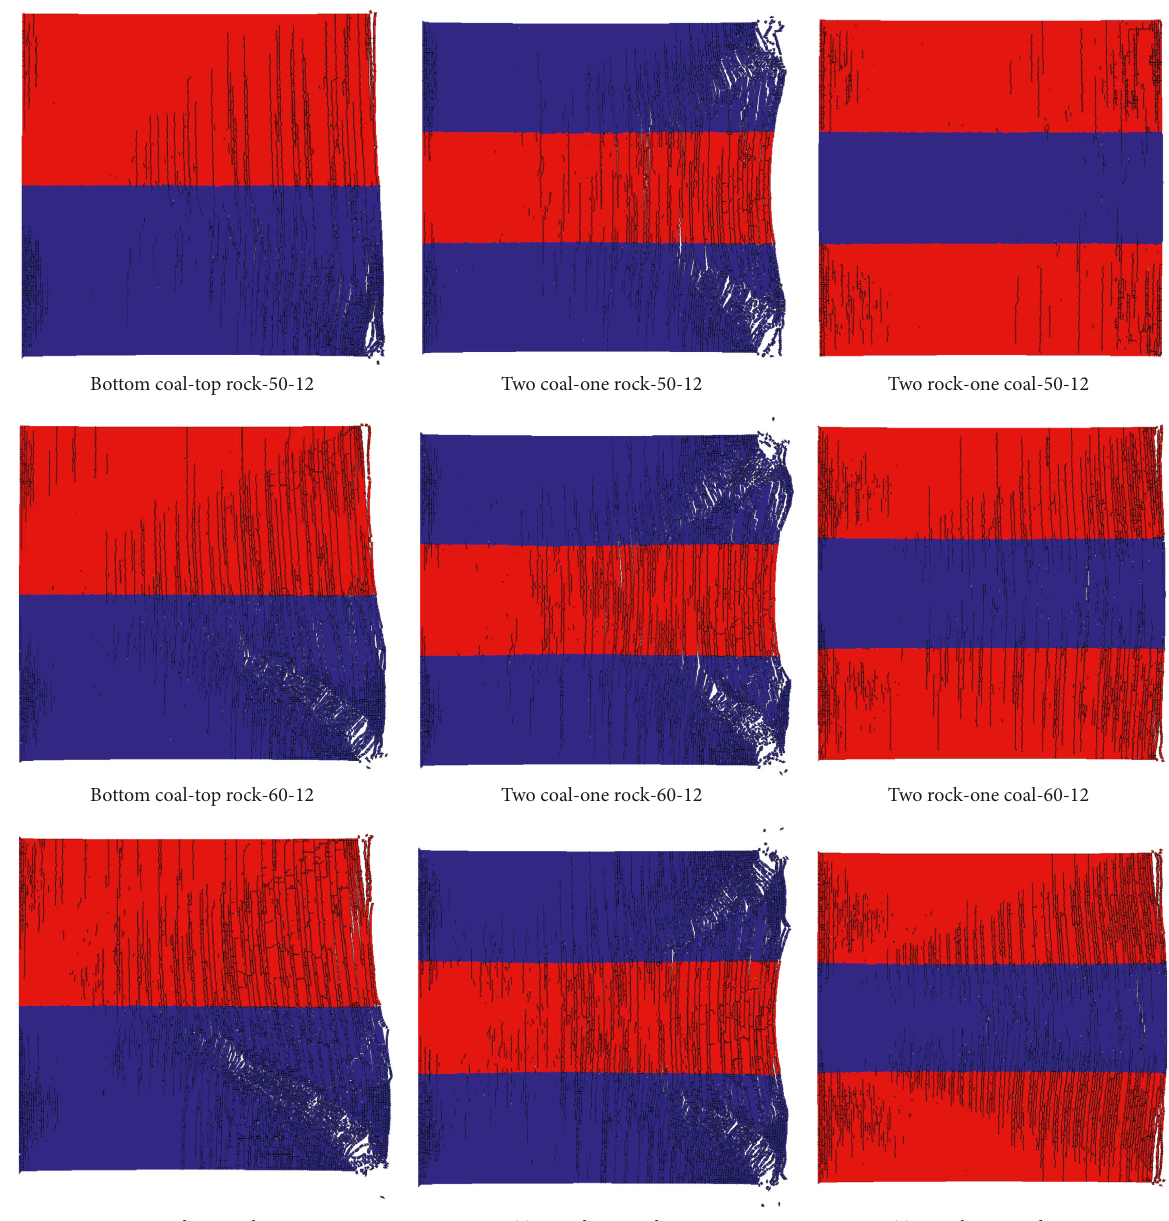
Figure 9: Failure results of rock sample after unloading the confining pressure. (a) Bottom coal-top rock, 50-12; (b) top coal-one rock, 50- 12; (c) two rocks-one coal, 50-12; (d) bottom coal-top rock, 60-12; (e) top coal-one rock, 60-12; (f) two rocks-one coal, 60-12; (g) bottom coal-top rock, 70-12; (h) top coal-one rock, 70-12; (i) two rocks-one coal,